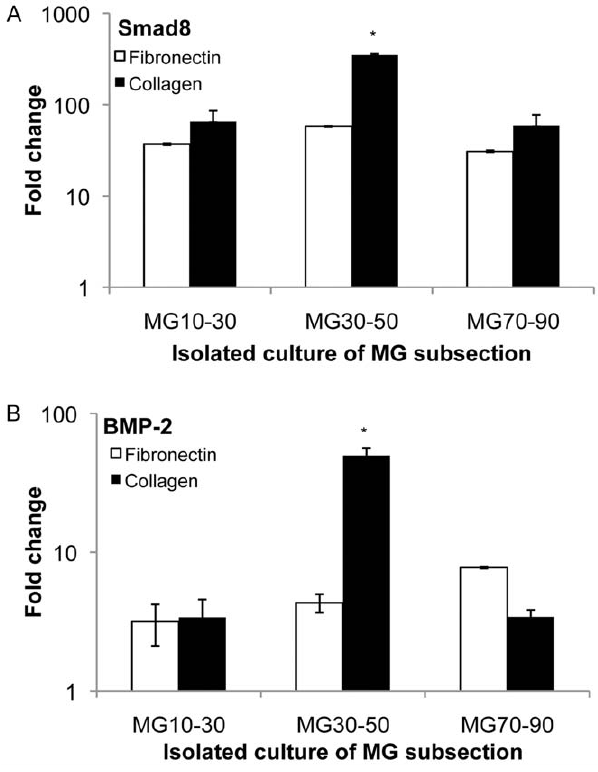
Figure 8. Substrate gene-level expression of Smad8 and BMP-2 from individual MG subsections. (A–B) Smad8 and BMP-2 were assessed from individual (narrow range) MG subsection cultures, also exhibiting trends similar to scleraxis from MG subsection studies described earlier, with maximum expression on the MG30–50 collagen substrate. * statistical difference (p , 0.05) compared to MG10–30 culture condition.